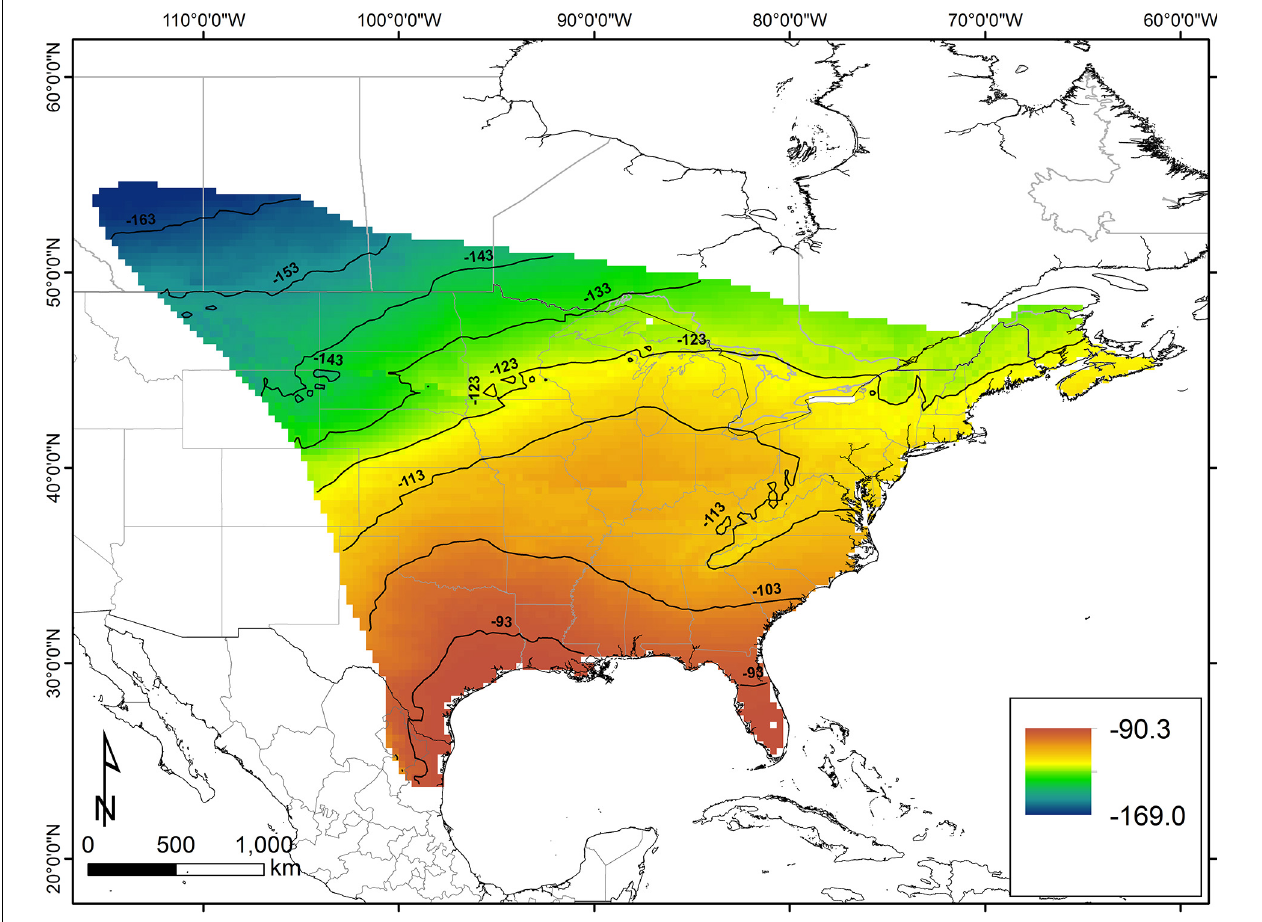
FIGURE 2 | Predicted wing δ 2 H isoscpae for the eastern population of North American monarch butterfly. Surface was based on the use of a predicted amount-weighted mean growing season precipitation δ 2 H dataset (Terzer et al., 2013) and the precipitation-to-wing calibration algorithm of Hobson et al.